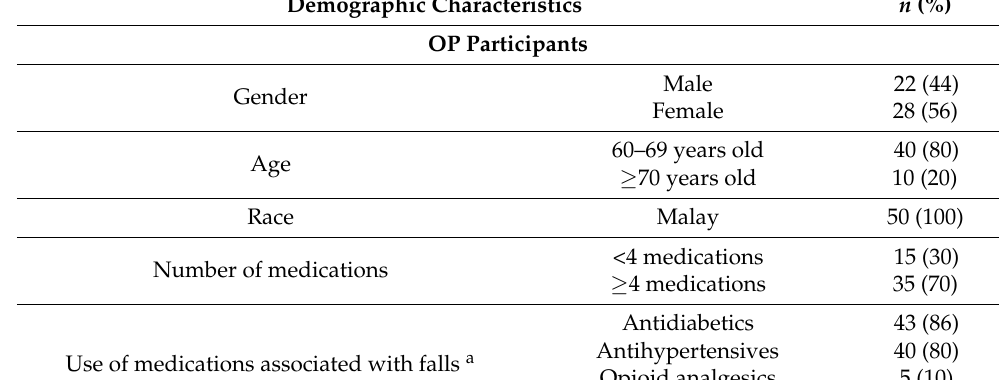
Table 4. Demographic characteristics of OP ( n = 50) and FCGs ( n = 50) who participated in the study. Demographic